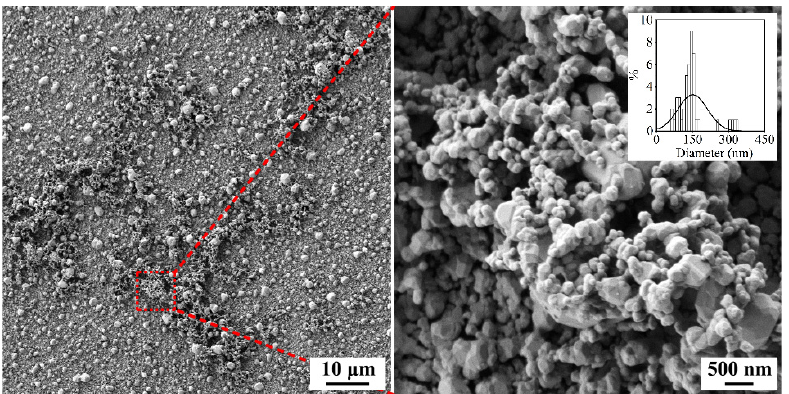
Figure 5. SEM micrographs of the dark area of the Ag-film surface grown in hydrothermal conditions at 100 °C.